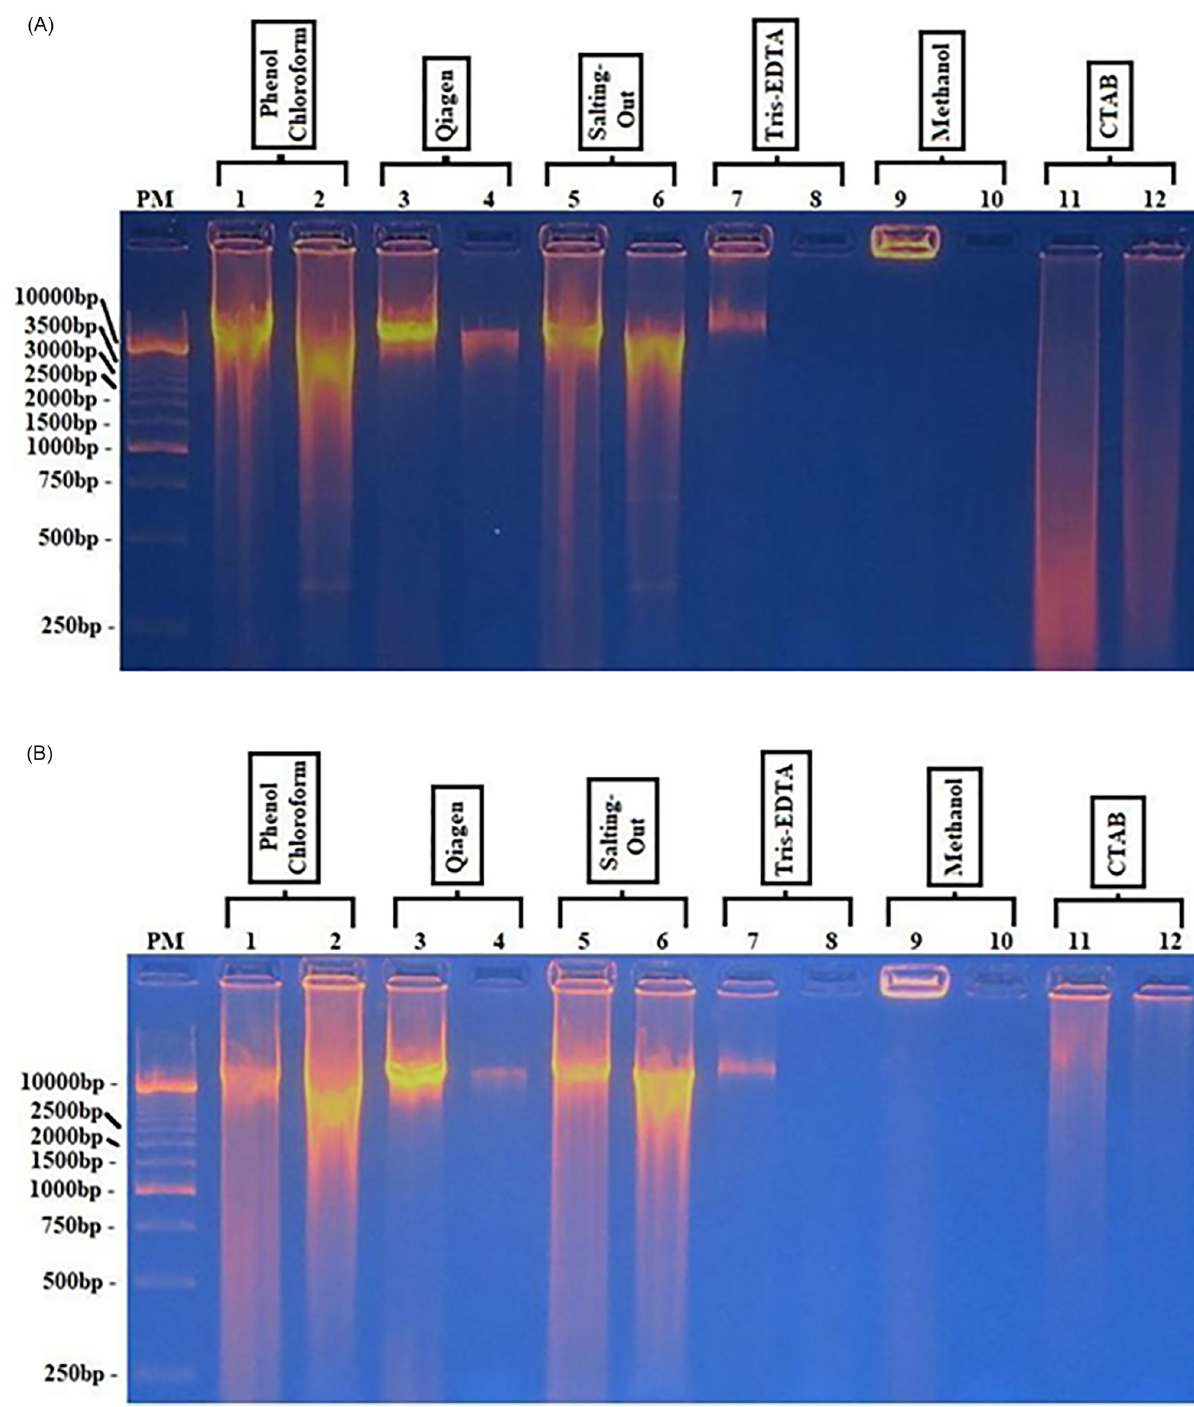
Fig 2. Digestion of extracted Loa loa DNA by EcoRI and BamHI endonuclease. 2A : Undigested (lines: 1-3-5-7-9-11) compared to digested with EcoRI (lines: 2-4-6-8-10-12) DNA; extracts were analyzed via agarose gel electrophoresis (1%) and visualized under UV light. The values on the left indicate the size of the bands. PM = molecular marker. 2B : Undigested (lines:1-3-5-7-9-11) compared to digested with BamHI (lines:2-4-6-8-10-12) DNA; extracts were analyzed via agarose gel electrophoresis (1%) and visualized under UV light. The values on the left indicate the size of the bands. PM = molecular